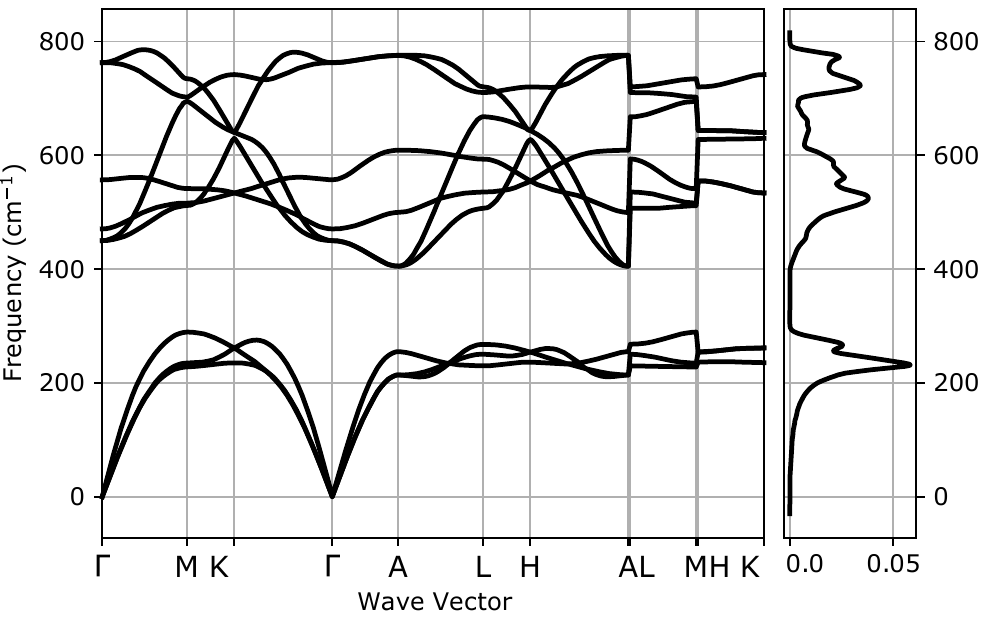
Figure 2. ZrB 2 ( hP3 -P6/mmm-space group, no. 191)-phonon band structure and densities of states (DOS).